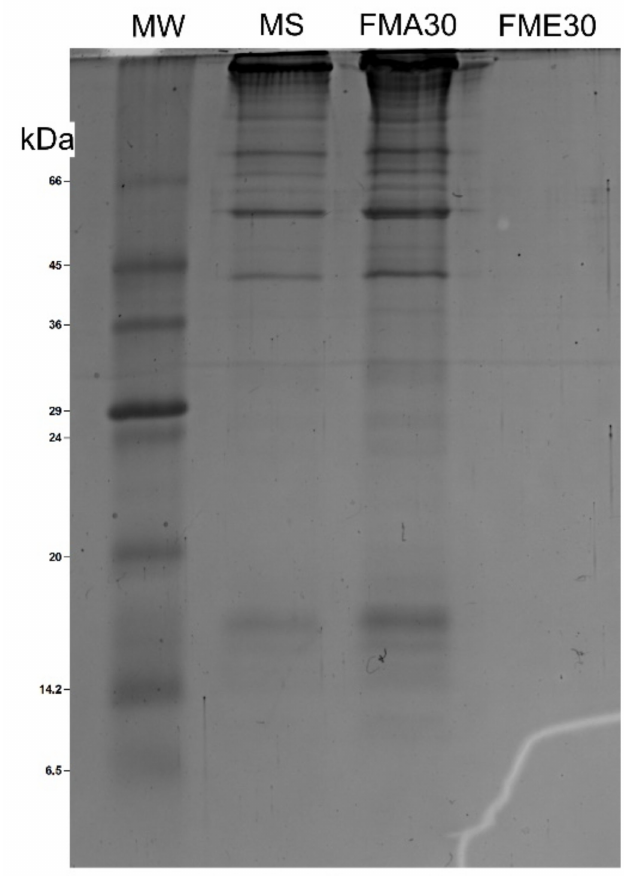
Figure 1. SDS-PAGE of separated fractions of mucus secretion of A. fulica. MW (molecular weight marker), MS (mucus secretion).